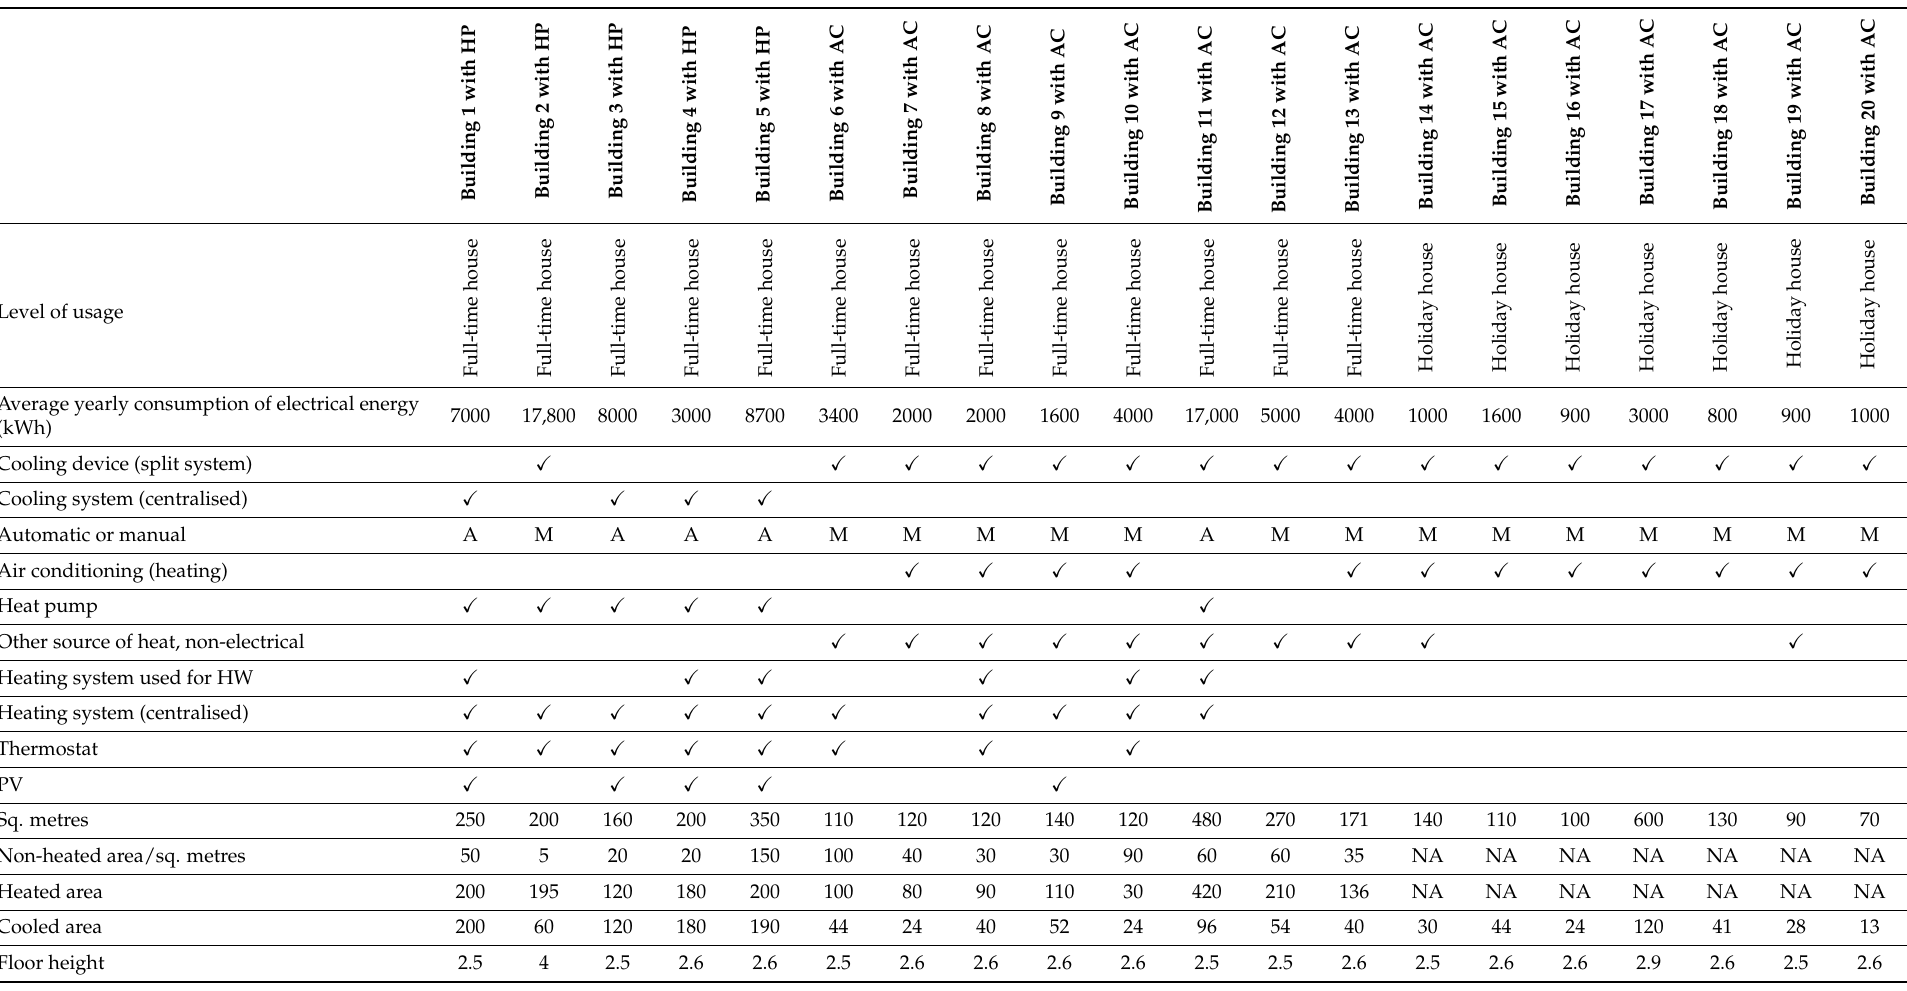
Table A1. Input data collected from the